Question: Express in one sentence what the figure is showing.
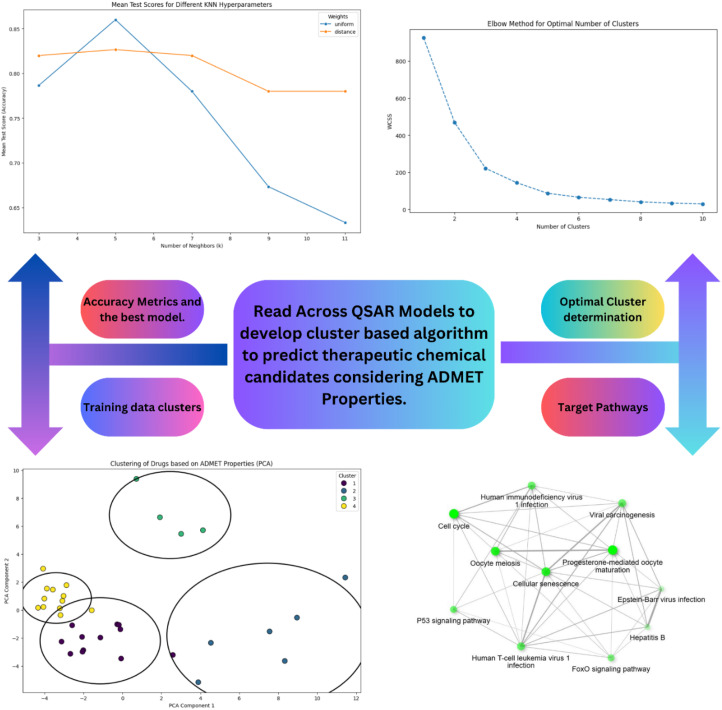
Answer: RASAR model to analyze the therapeutic drugs based on their pharmacological parameters and analyze the clustering based on the similarity of ADMET parameters among the chemical candidates. Additionally, we also included the accuracy metrics and model selection graph with the target biological pathways potentially involved with the MoA of the respective drugs